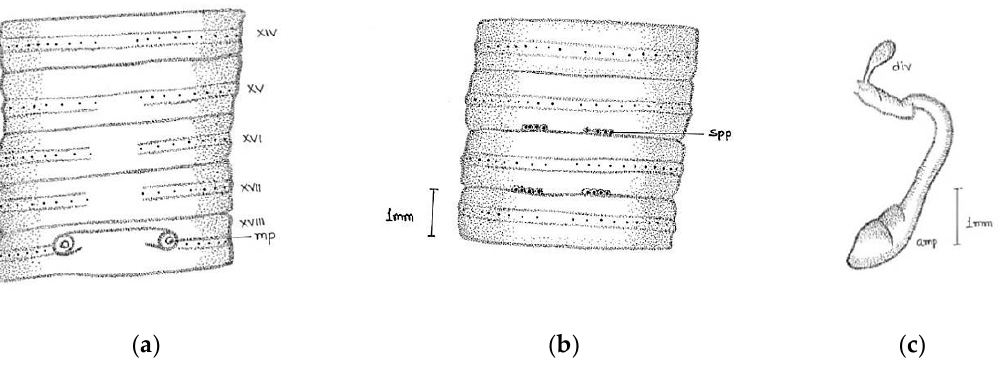
Figure 6. Camera lucida illustration of Megascolex polytheca polytheca ( a ) genital region; ( b ) spermathecal pore; ( c ) spermathecae.